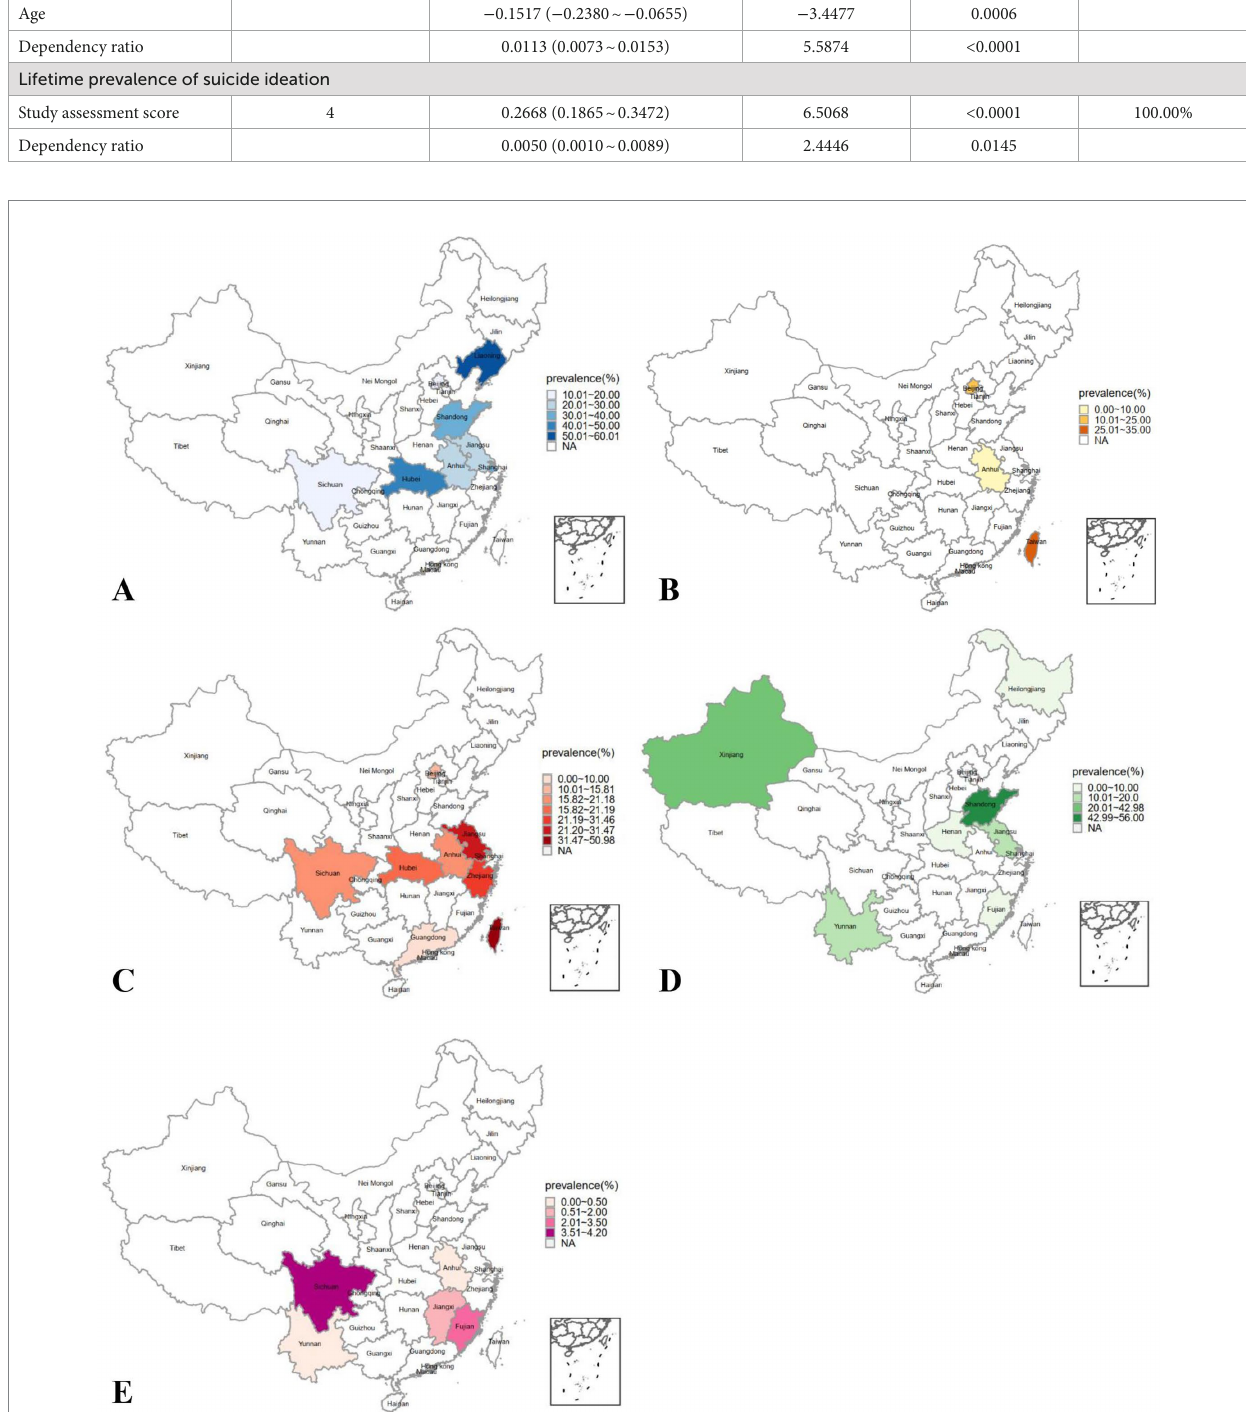
FIGURE 2 Distribution for prevalence of suicide ideation, self-harm and suicide among Chinese patients with schizophrenia. (A) lifetime prevalence of suicide ideation, (B) prevalence of suicide ideation at the time of the investigation, (C) lifetime prevalence of self-harm, (D) prevalence of self-harm during hospitalization, (E) suicide mortality; NA: not